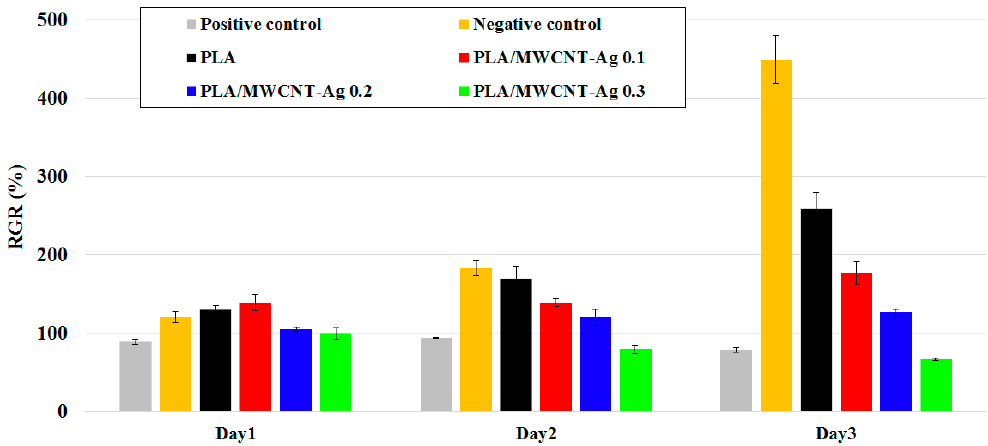
Figure 7. Methyl tetrazolium (MTT) assay results for the PLA and PLA/MWCNT-Ag nanocomposites.